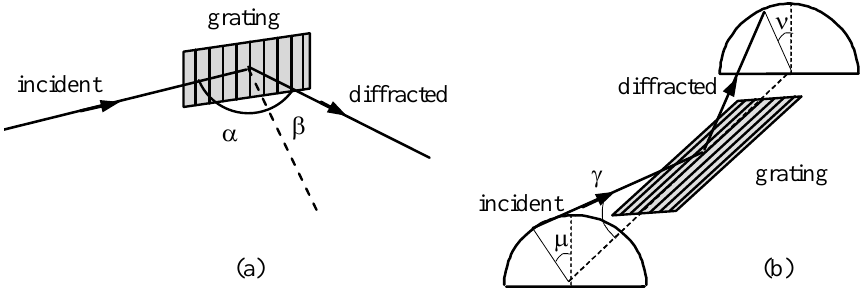
Figure 1. Grating geometries: ( a ) classical-diffraction mount (CDM); ( b ) off-plane mount (OPM).